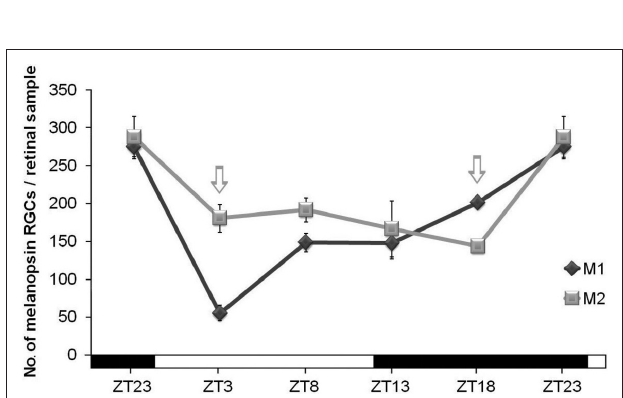
FIGURE 3 | Number of immunostained cells at ZT23 and ZT3 in the early postnatal development (mice were maintained under an LD cycle). Signifi cant differences could be detected at P5 ( p < 0.01), but not at P1. ( n = 4 per group at both time-points).